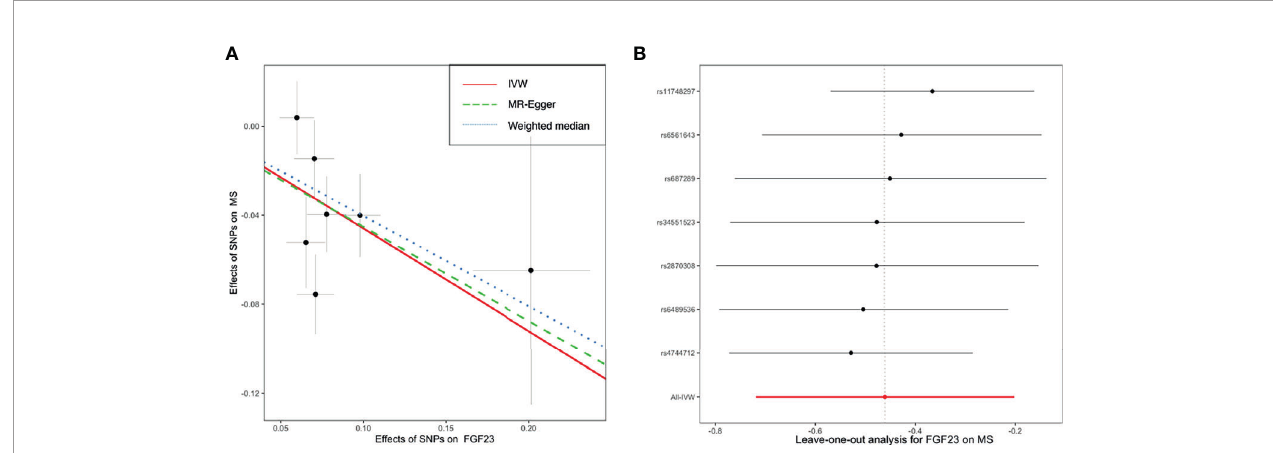
FIGURE 3 | The scatter plot (A) and leave-one-out plot (B) in the Mendelian randomization analysis of circulating FGF23 on the risk of MS. FGF23, fi broblast growth factor 23; IVW, inverse variance weighted; MS, multiple sclerosis; SNP, Single-nucleotide